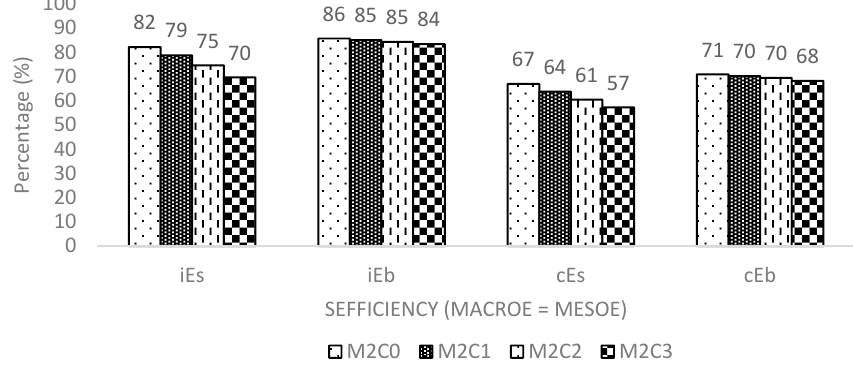
Figure 11. Sefficiency of M2C.